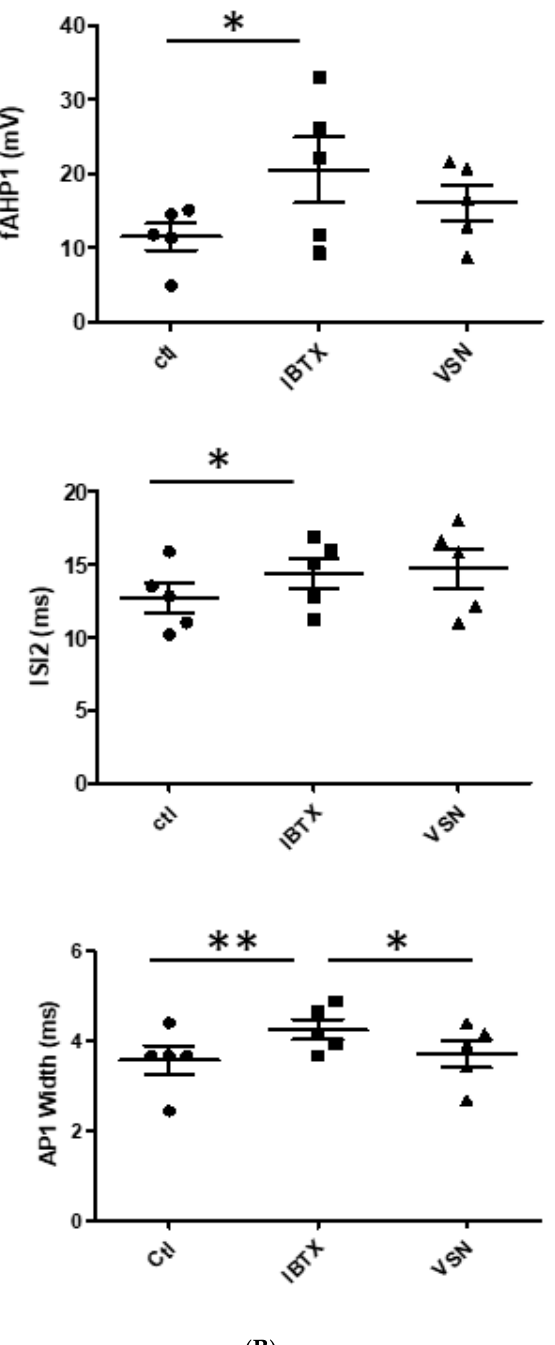
Figure 2. E ff ects of IBTX and VSN16R on AP waveform under high frequency stimulus. ( A ) Exemplar trace showing e ff ects of 100 nM IBTX and subsequent application of 100 µ M VSN16R. ( B ) E ff ects before (control) and at steady state after application of 100 nM IBTX and 100 µ M VSN16R on absolute change of first fAHP amplitude from resting potential, second ISI and first AP width. Data from n = 5 cells; * = P < 0.05; ** = P < 0.01.